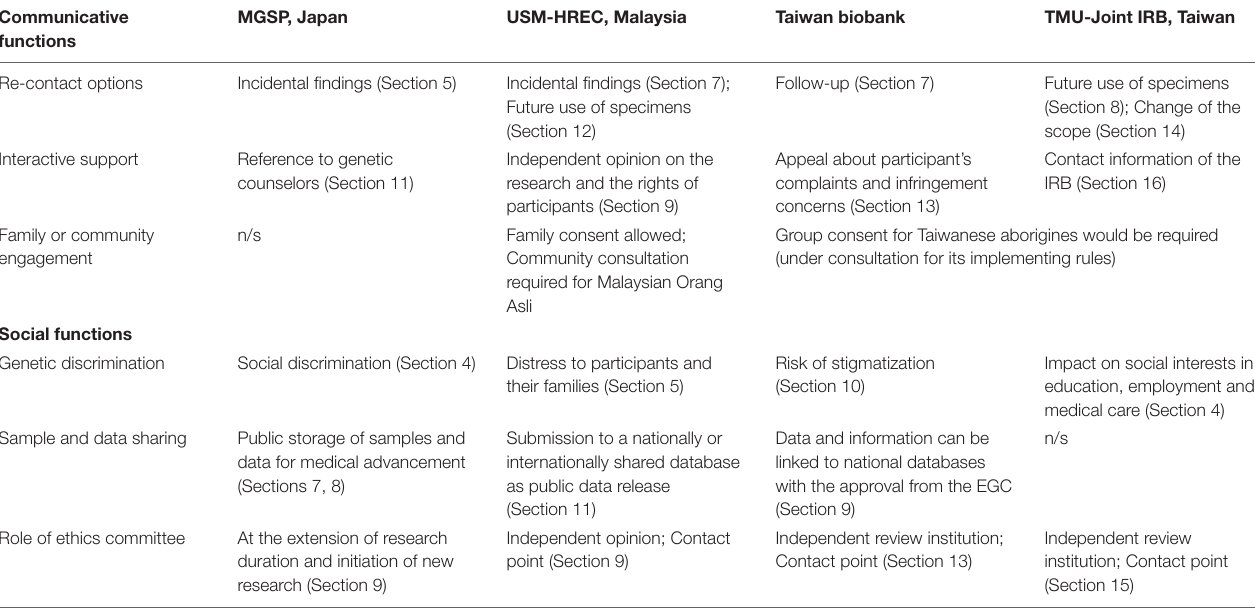
TABLE 1 | Statement on social and communicative functions in the